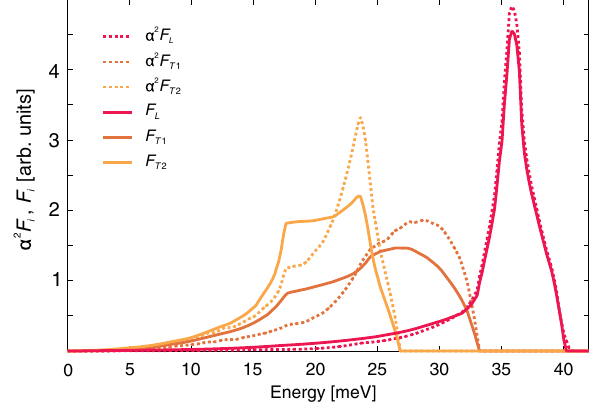
FIG. 8. Comparison of the spectral shapes of the partial Eliashberg functions α 2 F and partial phonon density of states i F . Each function is normalized to its i